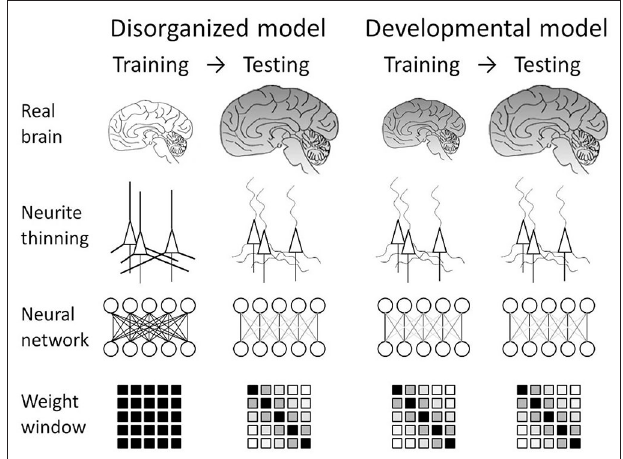
FIGURE 1 | Neural network models mimicking schizophrenia. Our nanotomography study revealed that neurites become thin and tortuous in schizophrenia. We translated this finding into two models. In the disorganized model, the structural alteration is incorporated as neurodegeneration after the formation of the brain network. This can be simulated by training the network in the usual manner and then testing it while damping weights between distal nodes. The developmental model assumes concurrent progress of neuropathological changes and brain development. This can be simulated by using a connection-modified layer, in which distal connections are damped during both training and